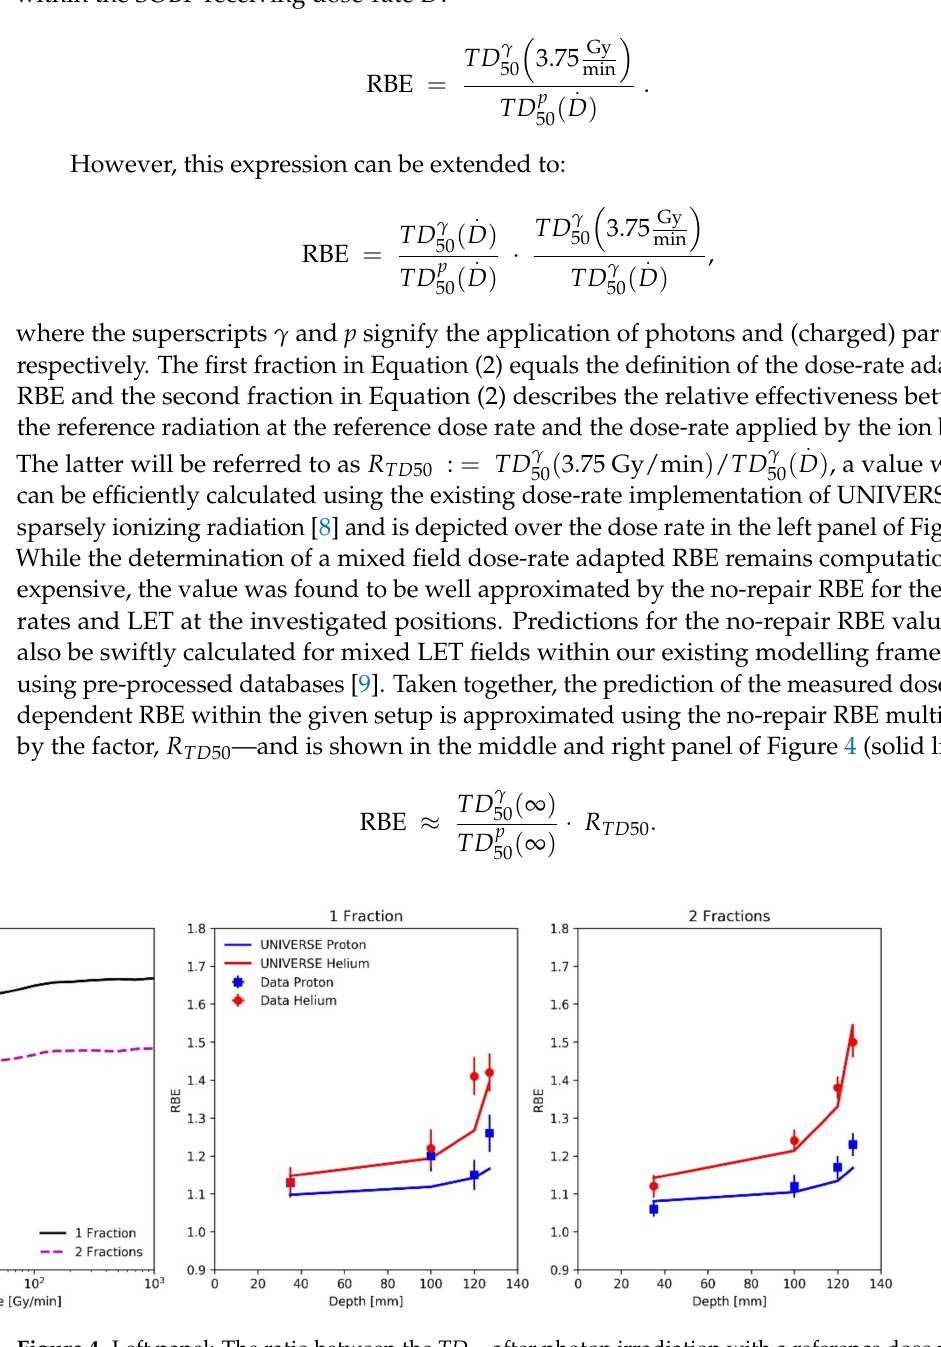
Figure 4. Left panel: The ratio between the TD 50 after photon irradiation with a reference dose rate of 3.75 Gy/min and a given dose rate ( R TD 50 ) as a function of the dose rate for one fraction (black line) and two fractions (dashed purple line). Middle panel and right panel: RBE for TD 50 of the rat spinal cord tolerance after application of a proton SOBP (blue squares; taken from Saager et al. [23]) and a helium SOBP (red circles; taken from Hintz et al. [24]) in one and two fractions with corresponding UNIVERSE predictions (solid